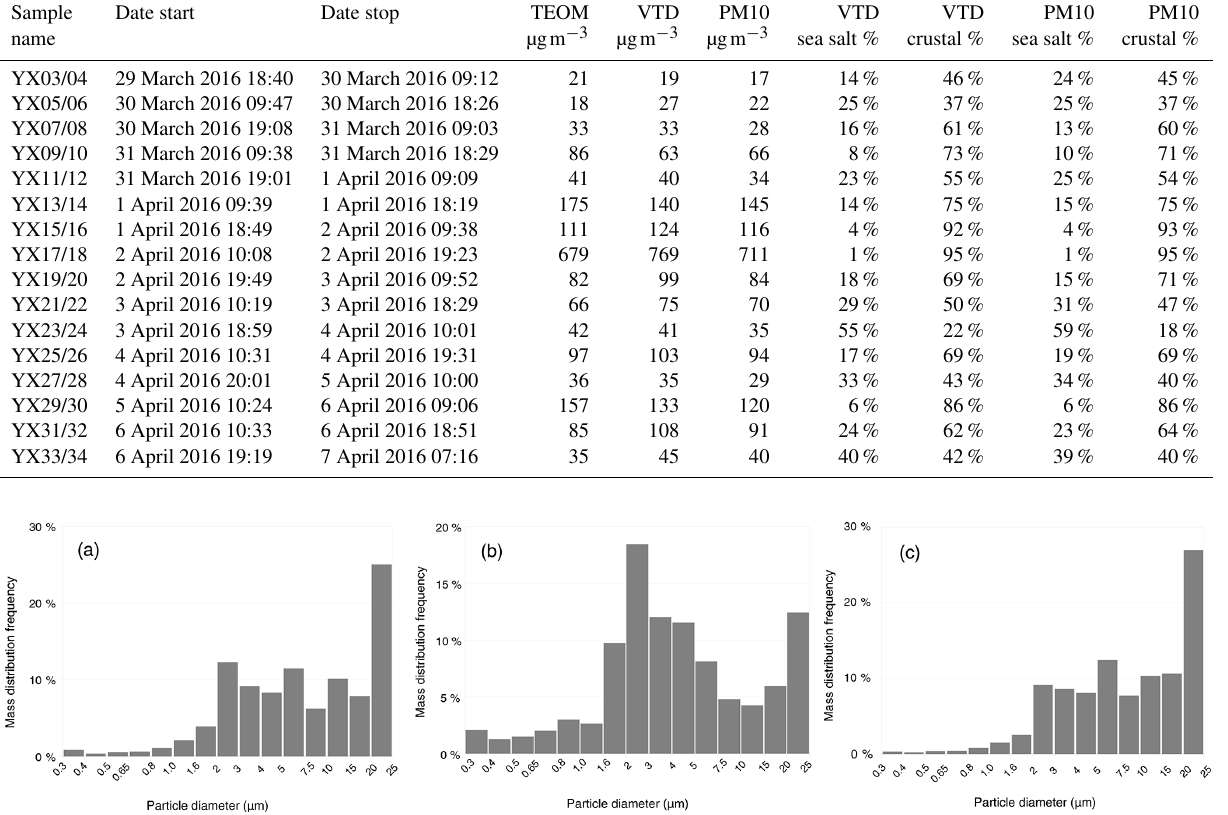
Figure 5. Daily average particle mass concentration size distribution in air on 31 March ( a , aerosol concentration ca. 40µgm − 3 ), 6 April ( b , aerosol concentration ca. 100µgm − 3 ), and 2 April, morning ( c , aerosol concentration ca. 700µgm − 3 ). Measured using the Grimm